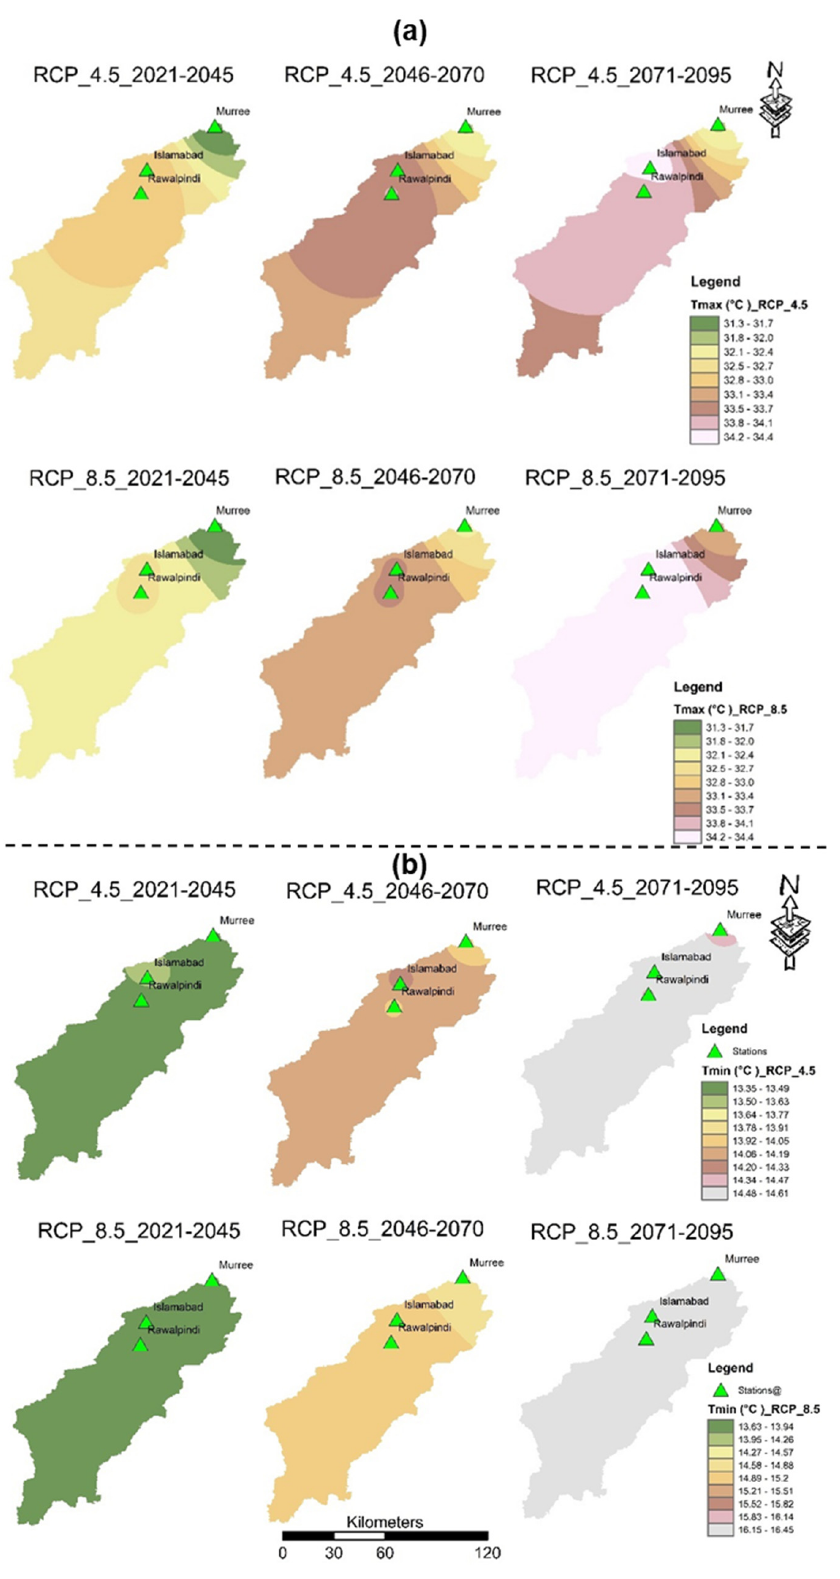
Figure 8. ( a ) Spatial distribution of maximum temperature ( T max ), and ( b ) minimum temperature ( T min ) data in the SRB for early, mid, and late century under both RCP-4.5, and